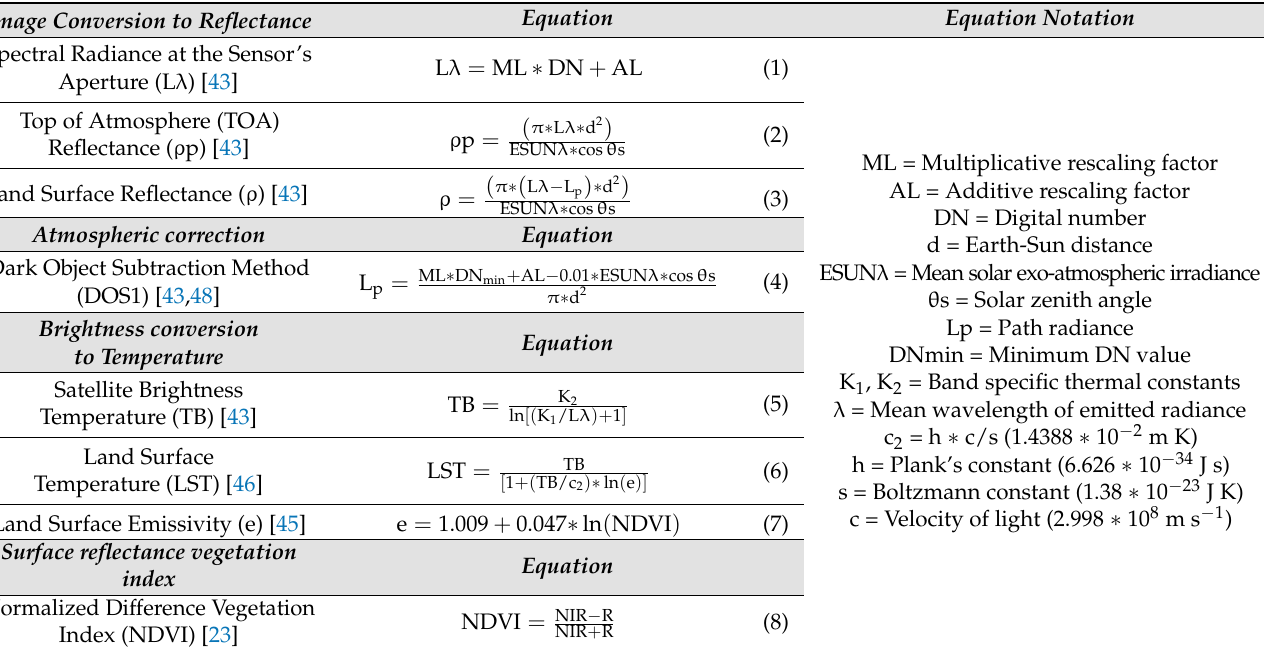
Table 2. Spectral bands preprocessing procedure. Radiometric and atmospheric corrections, bright- ness conversion to temperature, and the Normalized Difference Vegetation Index calculation steps for 307 tiles of Landsat. Datasets covered 26 hydrological years in the Guadalupe Valley Basin, Baja California,